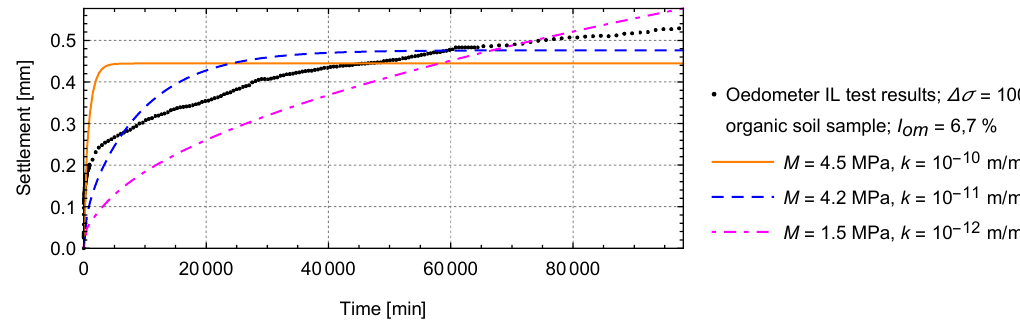
Figure 2. Terzaghi solution in comparison to test